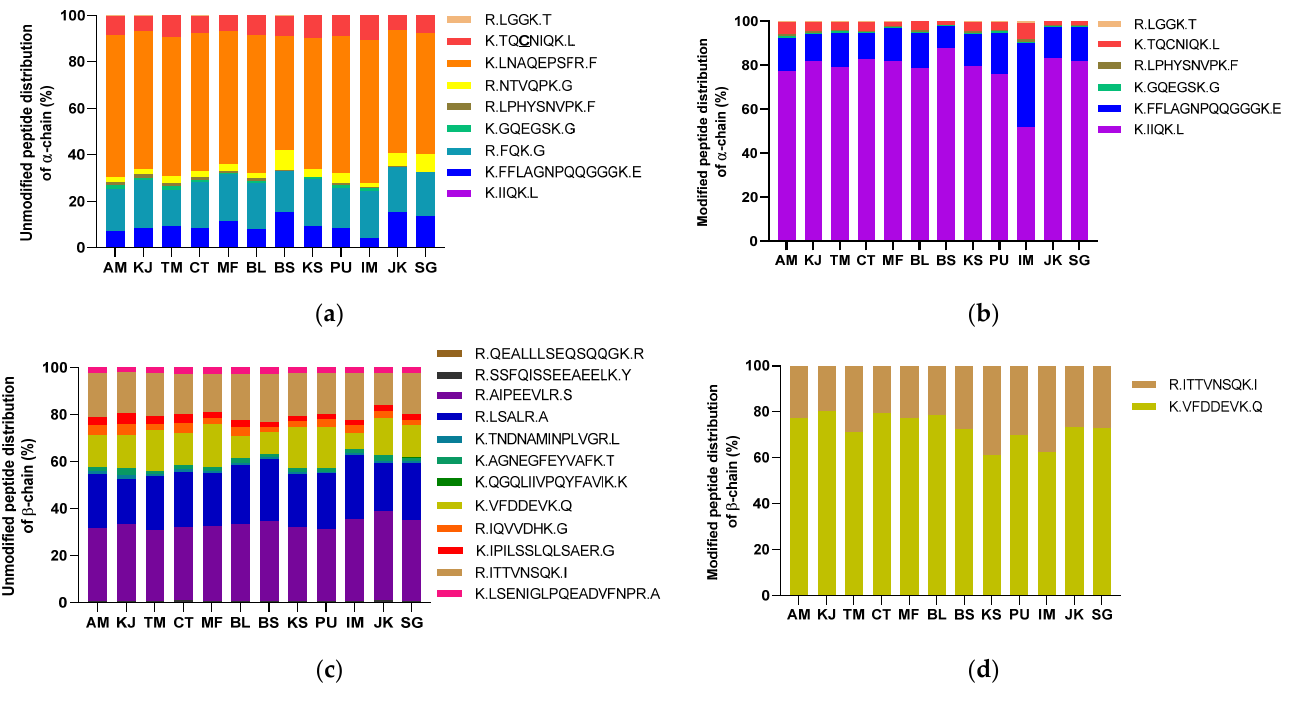
Figure 5. Distribution of the unmodified and modified peptides of the α -chain ( a , b ) and β -chain ( c , d ) of 11S by HPLC-MS/MS. AM: Maji Ethiopia; KJ: Jora Kenia; TM: Mbeye Peak Tanzania; CT: Tarrazu Costa Rica; MF: Flaming Mexico; BL: Logoa Brazil; BS: Santos Brazil; KS: Supremo Colombia; PU: Urubamba Peru; IM: Malabar India; JK: Kayumas Indonesia; SG: Gayo Indonesia. In the case of the proportion of modified peptides in the β -chain (Figure 5d), Brazil Santos green coffee beans (BS) are particularly marked by the peptide R.ITTVNSQK.I